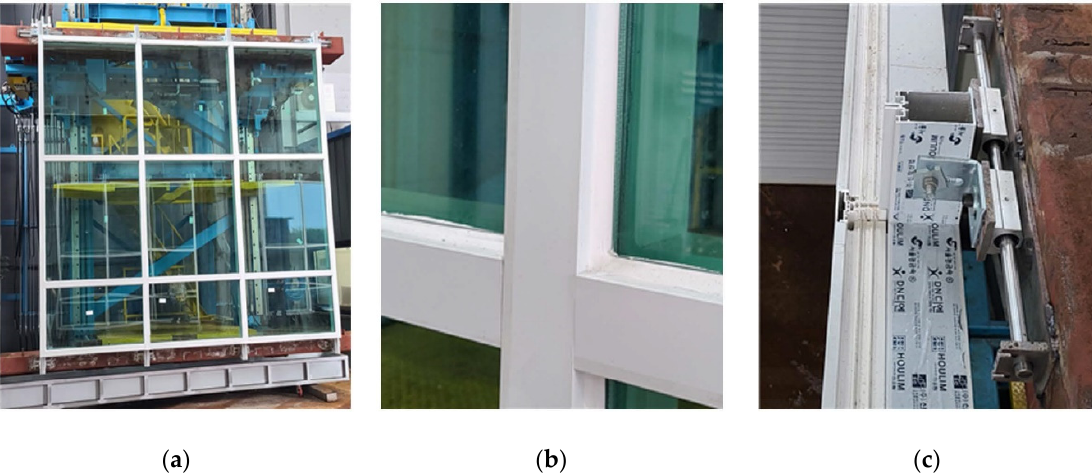
Figure 14. States of seismic curtain wall after the dynamic racking crescendo test: ( a ) no abnormalities detected in the front of the specimen; ( b ) no cracks or breakage of silicone; ( c ) no abnormalities detected in the upper fastener.